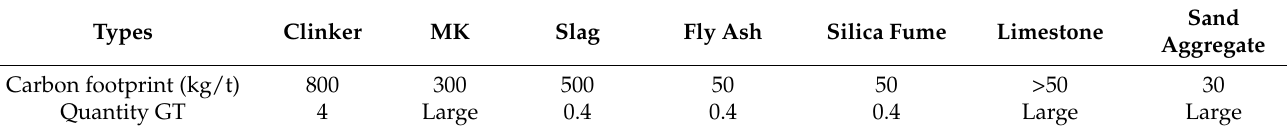
Table 2. Clinker and some of the major SCMs with their available or produced quantity, along with their typical carbon footprint [6,14]. The carbon footprint of slag is no longer considered waste at 50 kg CO 2 /t but a consumed product at 500 kg CO 2 /t